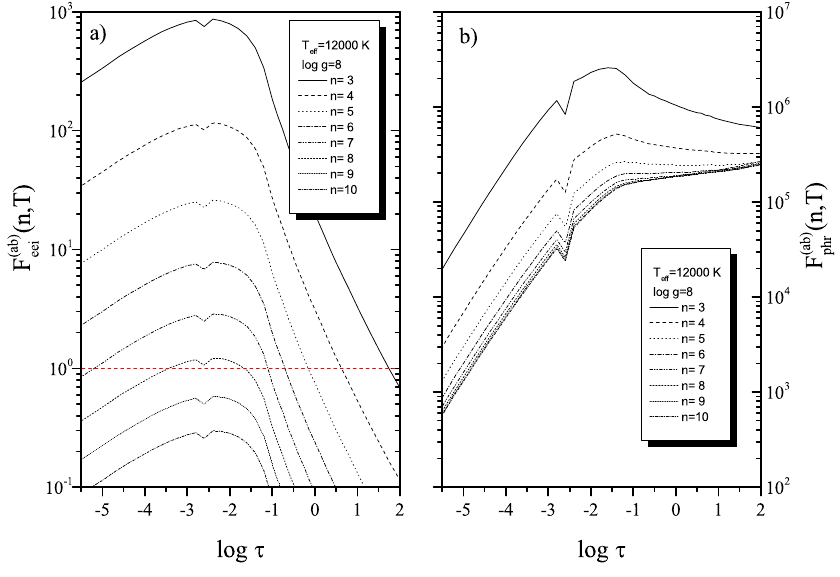
( ab ) ( n , T ) (8) as a function of the logarithm of the Rosseland optical depth eei ( ab ) ( n , T ) phr